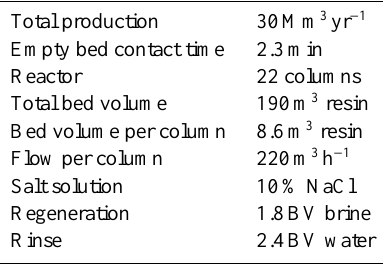
Table 2. Design of IEX